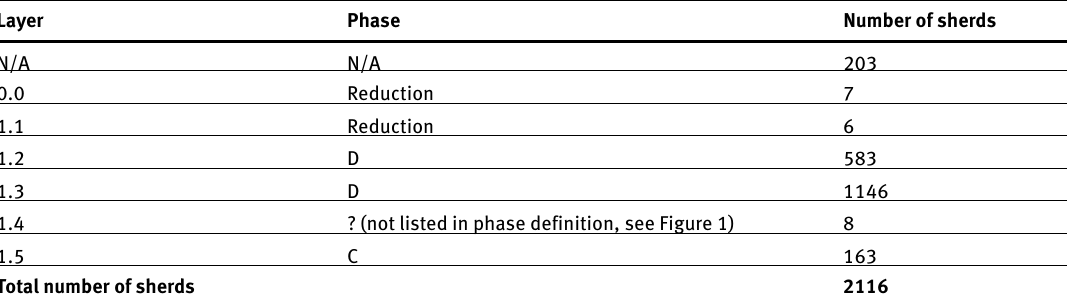
Table 2. Count of sherds per